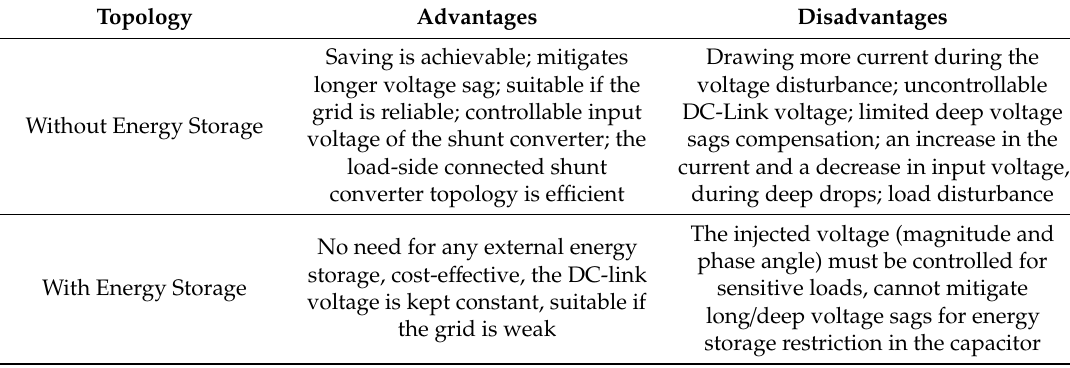
Table 5. The advantages and disadvantages of DVR topologies. Based on data from